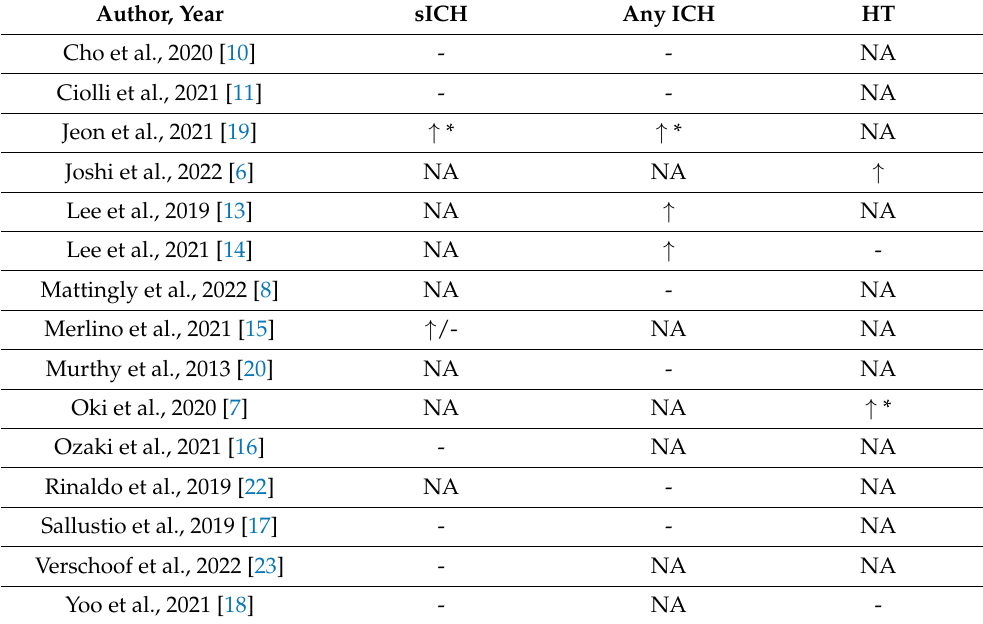
Table 4. Overview of symptomatic and any ICH, and hemorrhagic transformation tendencies in cancer patients compared to non-cancer